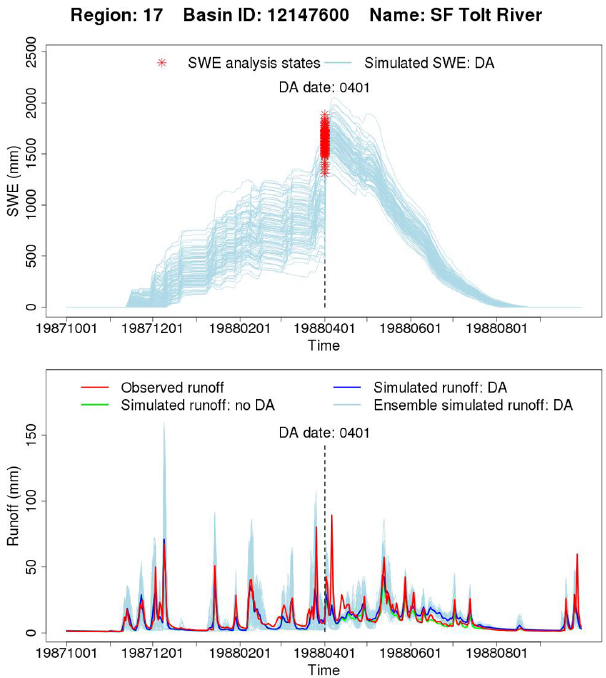
Figure 8. Time series plots for SWE and runoff for the Greys River for water year 1997. Light blue lines indicate individual ensemble member traces. Vertical black dashed line denotes the DA date.